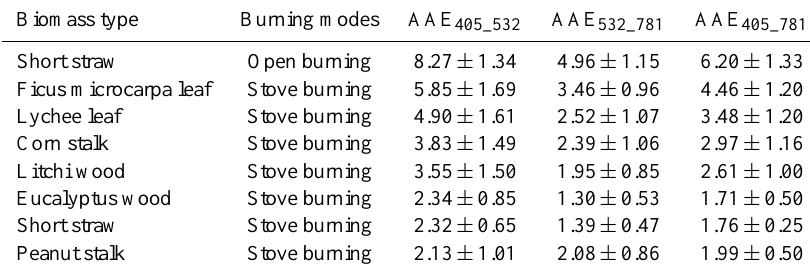
Table 4. The AAE values observed in the biomass burning simulation